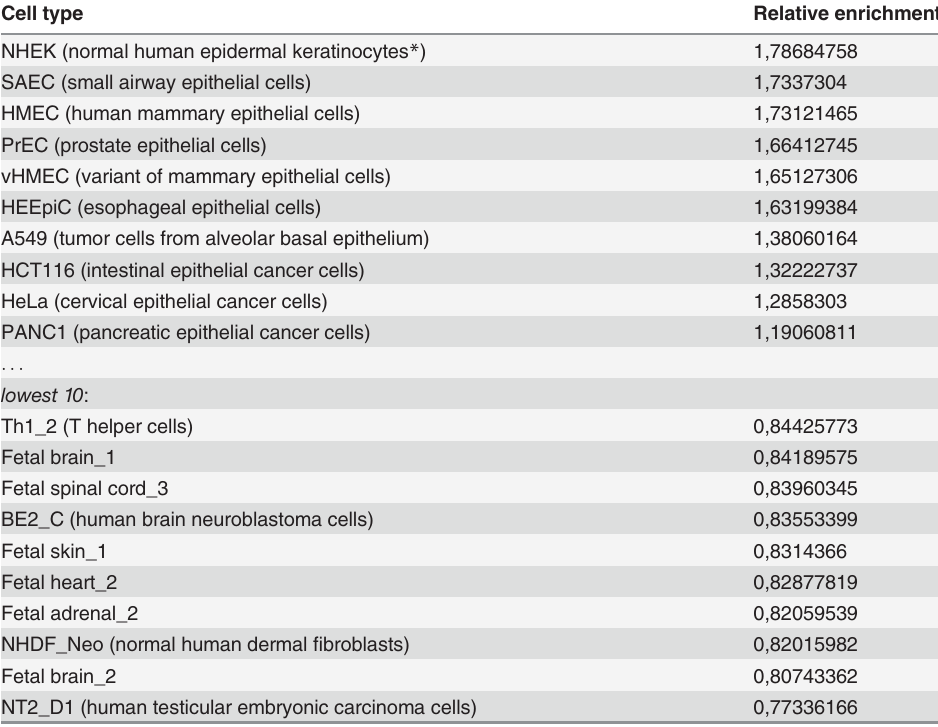
Table 3. Relative enrichment of HPV integration sites within regions marked as DNase hypersensitive across cell types. Cell